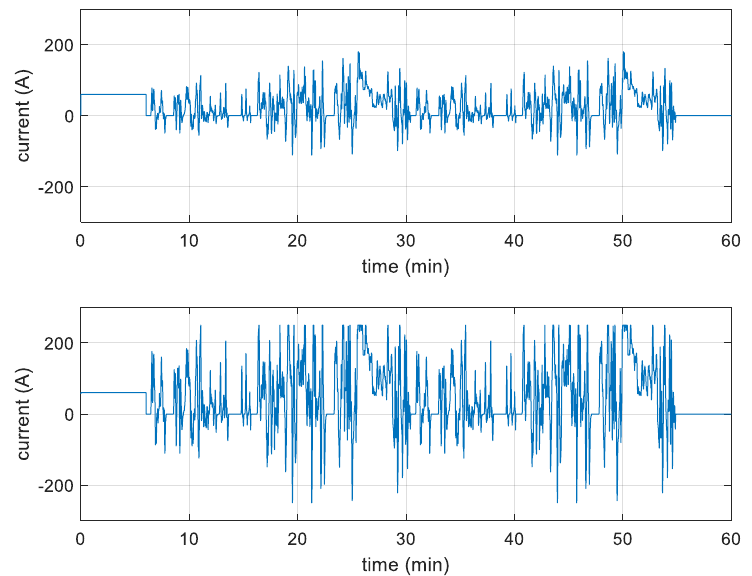
Figure 8. WLTC current profiles. First plot referring to validation test 1, the other referring to test 2. Positive current during discharge.